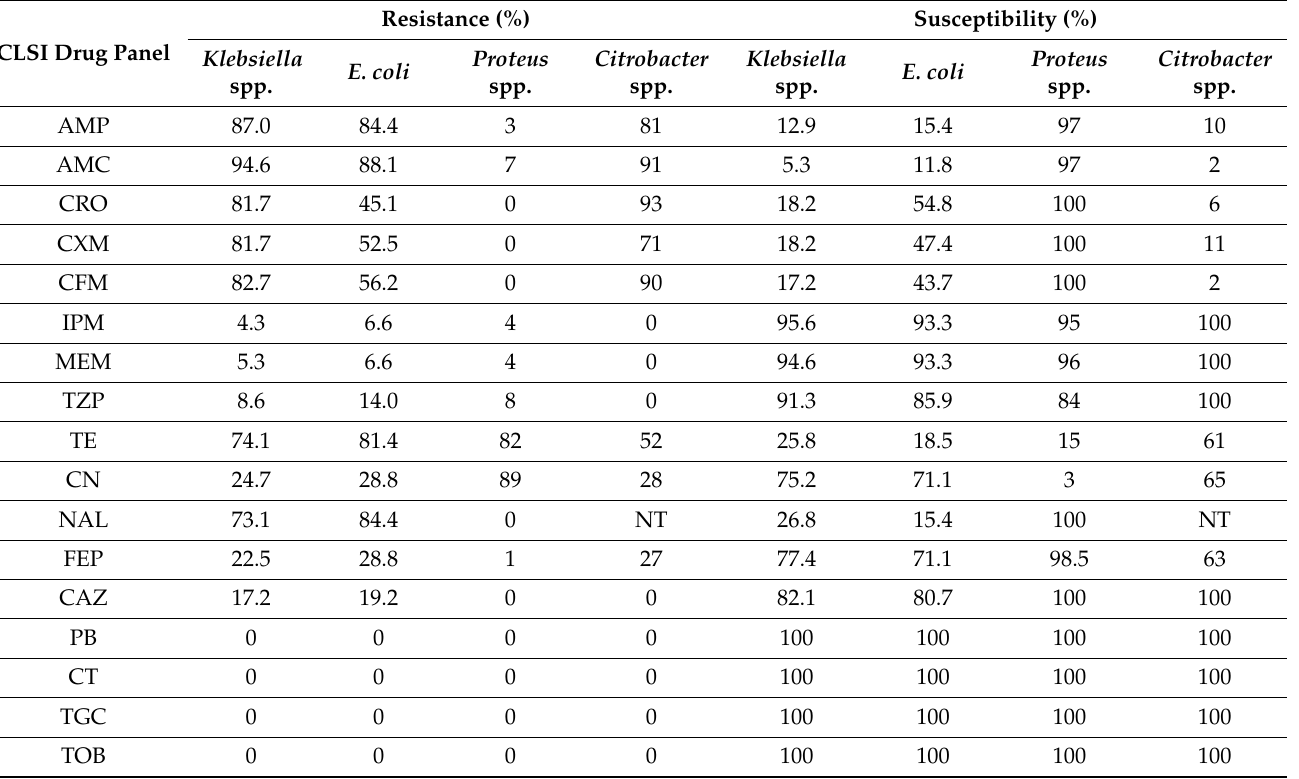
Table 4. The antibiotic susceptibility patterns of Klebsiella spp., E. coli , Proteus spp., and Citrobacter spp. with reference to CLSI